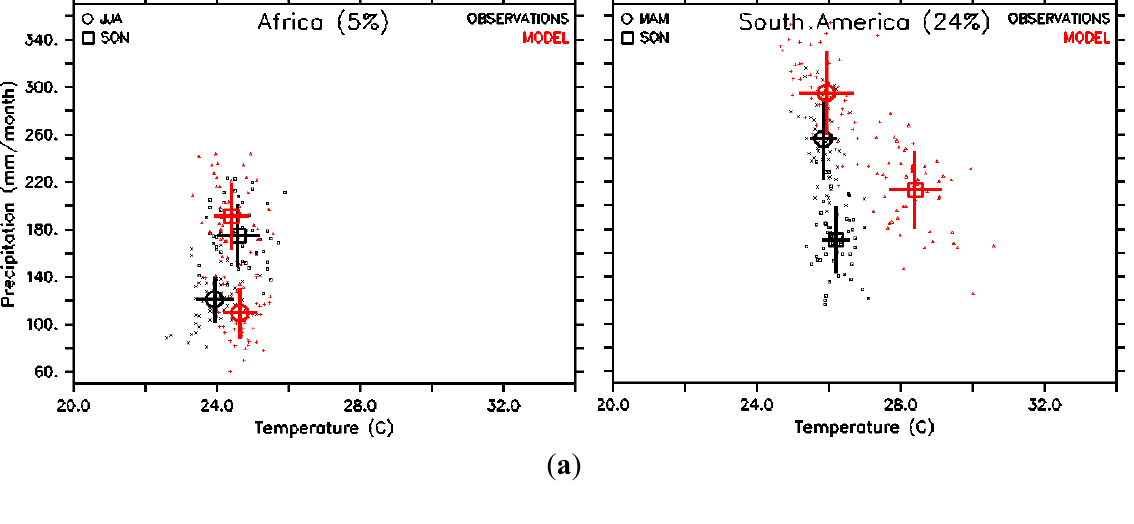
Figure 5. Seasonal Climate types Ar ( a ) and Dc ( b ). Each group of data represents observations and model results. Each dot represents the monthly mean value of precipitation and temperature in each month of the corresponding season. Seasons at each plot are identified by their different temperature-precipitation regime that results in two clusters of two groups of data. The seasons were chosen to represent the periods in which precipitation and/or temperature maximum and minimum values take place throughout the year, in this way, maximal annual amplitude is represented, note that the Ar climate type in Africa has two wet periods in the year (March, April, May and September, October, November), then June, July, August was selected as the dry season. The mean for both variables, temperature and precipitation, is represented by a square or a circle for each season. The bars represent the standard deviation. The percentage values correspond to the area covered by the climate type with respect to the total land area in the region. The period considered is 1989 to 2006.